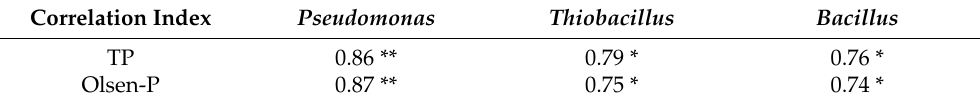
Table 5. Correlation analysis between phosphorus solubilizing bacteria and soil TP and Olsen-P. Correlation